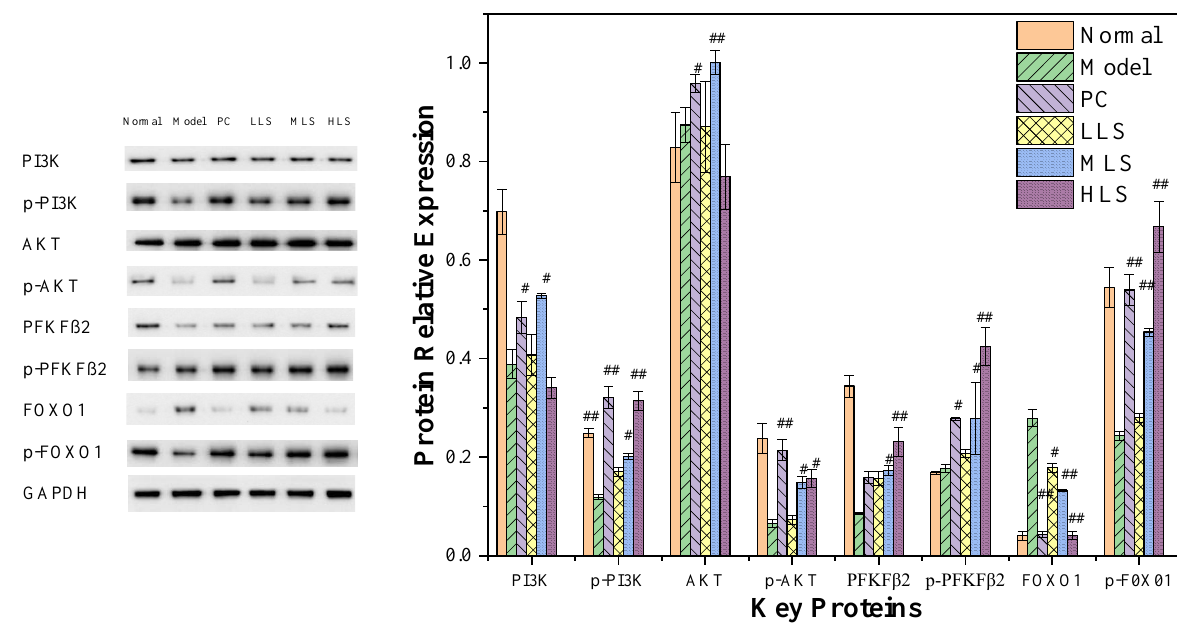
Figure 2. Effect of oral sericin on the expression of PI3K/AKT pathway proteins in T2D rats. Normal: normal group; Model: diabetic model group; PC: 0.5% melbin; LLS, MLS, and HLS: 1%, 2.5%, and 5% LS. n = 3, # p < 0.05, ## p < 0.01 versus model group.